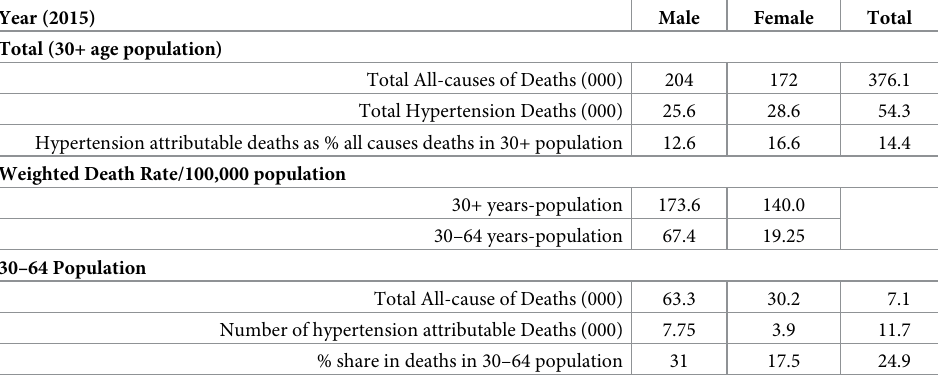
Table 5. Estimated deaths associated with hypertension in